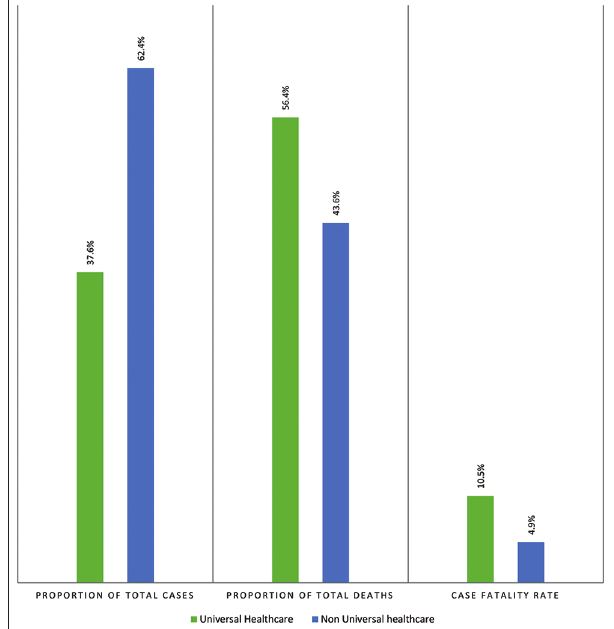
Figure 2: COVID-19 cases, deaths and case fatality rate by Universal Health Coverage (UHC) among high impact